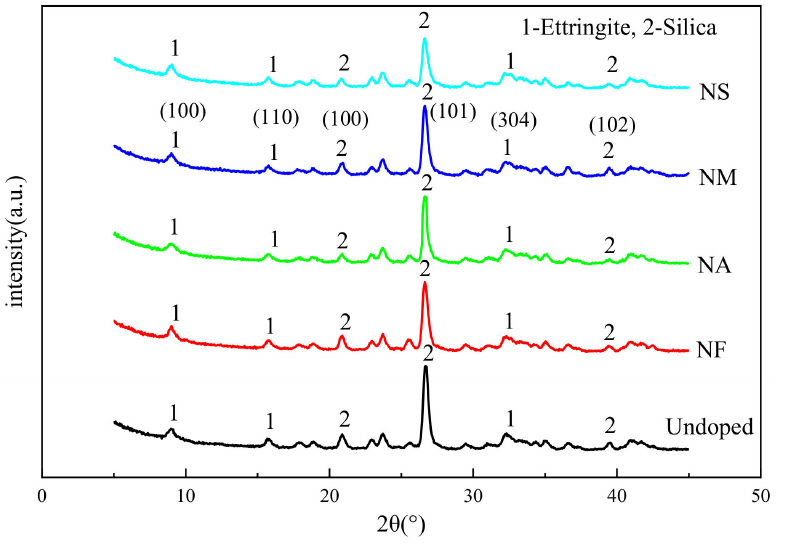
Figure 10. XRD curves of grouting materials with different